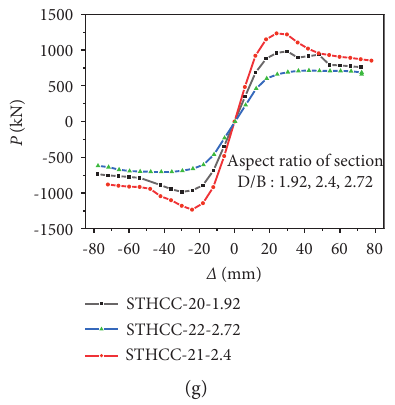
Figure 8: Skeleton curves of STHCCs with different parameters. (a) λ s : 2.08, 2.45, 2.64, 3.33. (b) f ck : 30MPa, 40 MPa, 50 MPa, 60 MPa. (c) n : 0.1, 0.2, 0.3, 0.4. (d) α : 0.021, 0.032, 0.044, 0.056. (e) f yfk : 235 MPa, 335MPa, 390MPa, 420MPa. (f) D / B :1.89, 1.73, 1.6. (g) D / B :1.92, 2.4, 2.72.